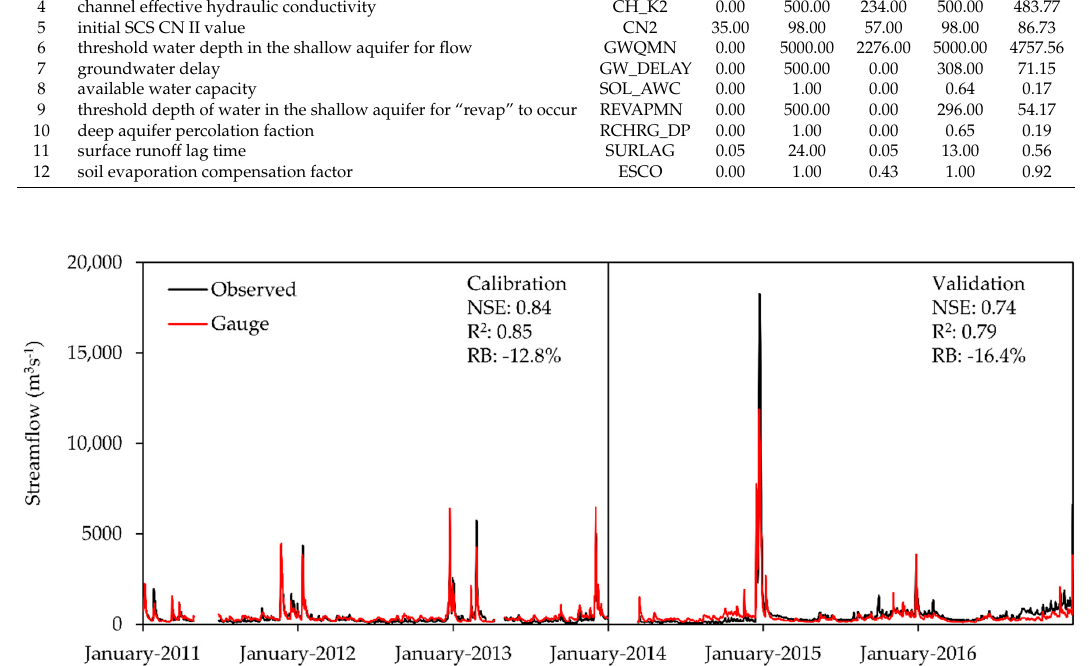
Figure 4. Calibration (1 January 2011–31 December 2013) and validation (12 March 2014–31 December 2016) of the SWAT-simulated daily streamflow with observed streamflow at the Jambatan